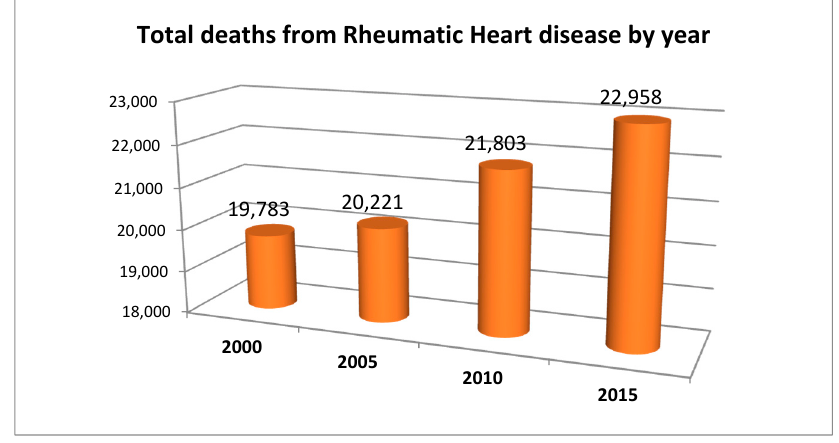
Figure 2. Comparison of the trends in total deaths from rheumatic heart disease in the Eastern Mediterranean region from the year 2000 to 2015.